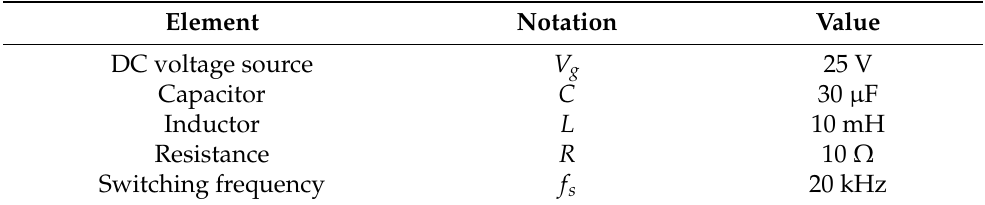
Table 1. Parameter values of buck–boost converter in Figure 1.